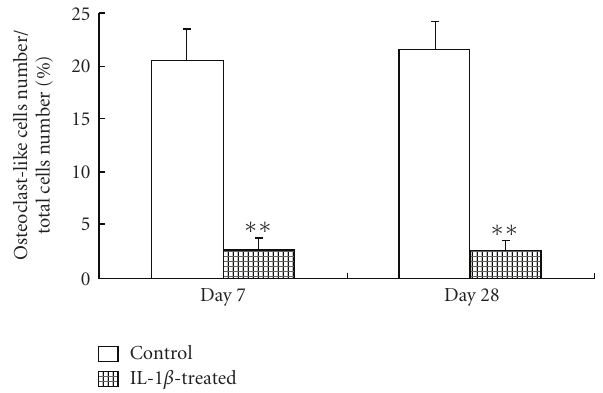
Figure 6: E ff ect of IL-1 β on osteoclast di ff erentiation estimated by the number of TRAP-positive multinucleate cells. Cells were cultured in DMEM containing 10% FBS with or without 100U/mL IL-1 β for 7 or 28 days. RAW264.7 cells were cultured under the conditions described in Figure 5. TRAP-positive multinucleate cells with more than three nuclei were considered osteoclasts, and the data were converted to the percentage of TRAP-positive multinucleate cells of the total number of cells. Each bar indicates the mean ± SD from separate experiment. ∗∗ P < . 01 for IL-1b treatment versus the